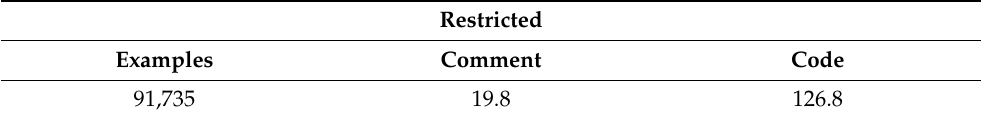
Table 3. Number of restricted comments and code character length. The comment character average length is limited to 40. The code character length is limited to